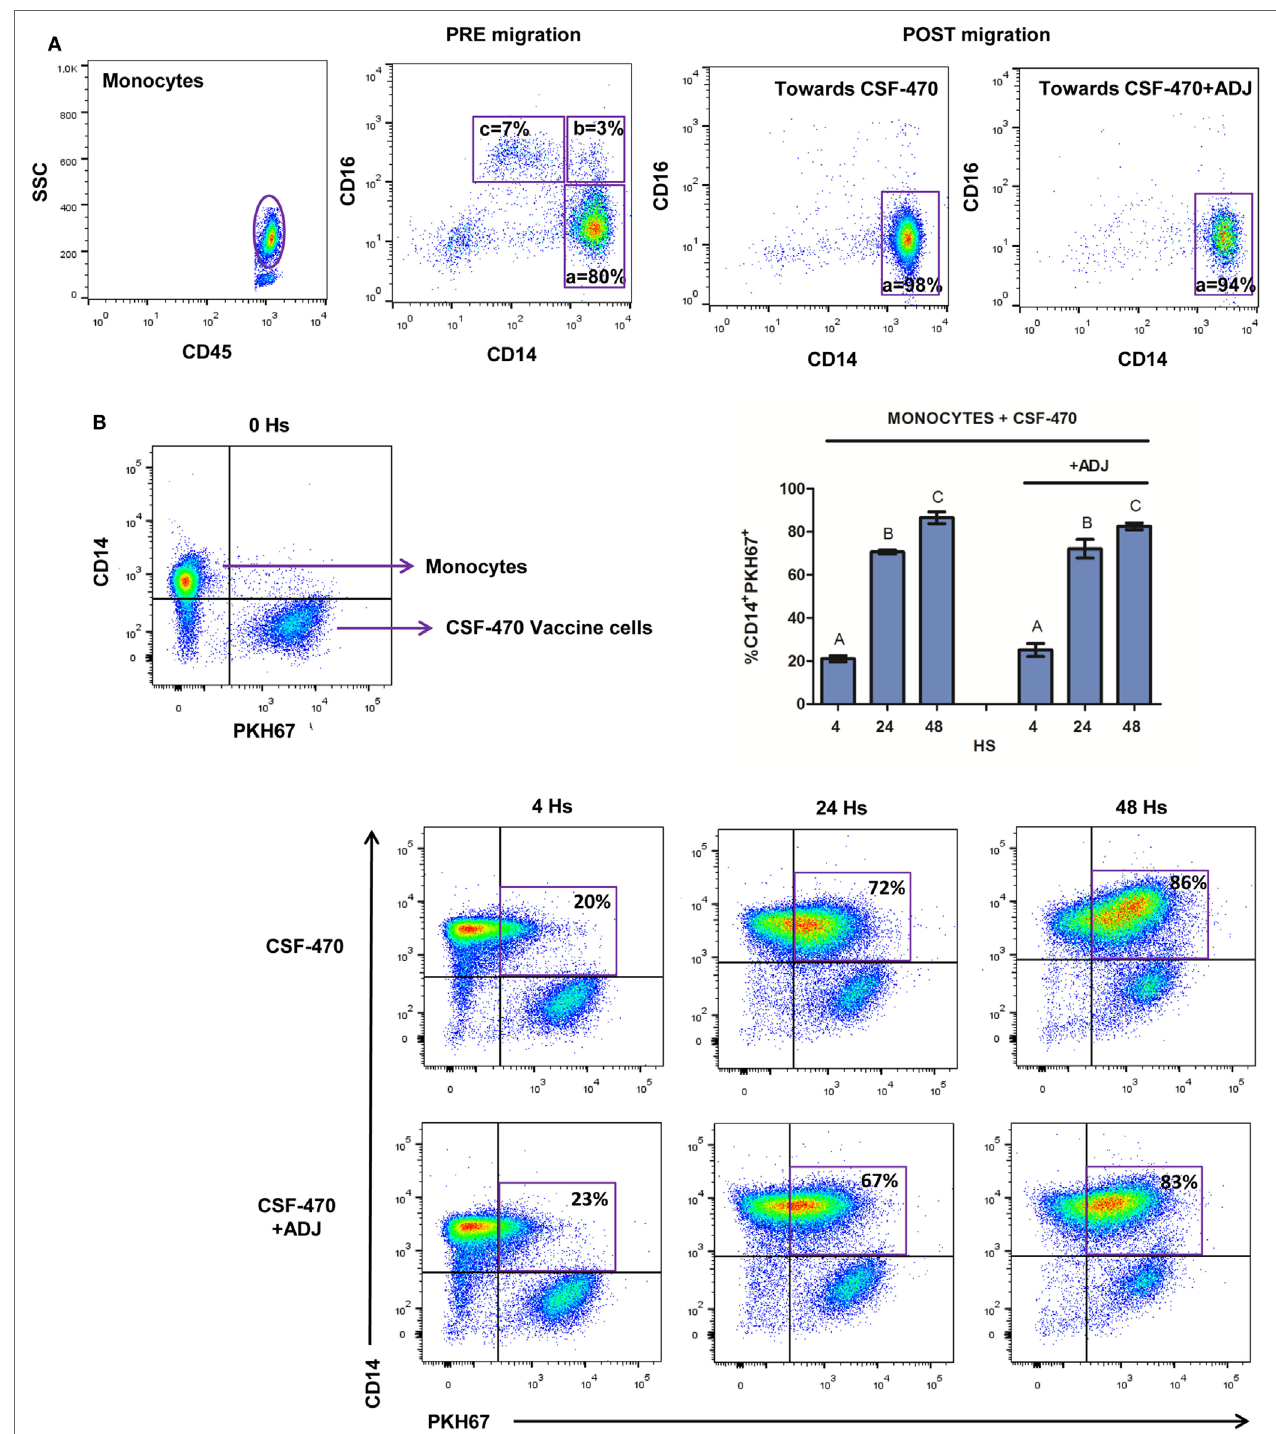
FigUre 2 | Classical monocytes migration and phagocytosis of irradiated cells. (a) Proportion of classical (a = CD14 ++ CD16 − ), intermediate (b = CD14 ++ CD16 + ), and nonclassical monocytes (c = CD14 + CD16 ++ ) PRE and POST migrations toward CSF-470 vaccine, with or without adjuvants bacillus Calmette–Guerin and granulocyte macrophage colony-stimulating factor (ADJ). One representative experiment is shown. (B) Phagocytosis of CSF-470 vaccine cells at 4, 24, and 48 h. Selected gates represent the percentage of monocytes that have phagocytose-labeled material from CSF-470 vaccine. Bars represent the percentage of monocytes from healthy donor ( n = 3) that uptake irradiated CSF-470 cells (double staining CD14 + PKH67 + ) at 4, 24, and 48 h. Bars with different letter are statistically different ( p < 0.05). To illustrate, representative dot plots from one experiment are